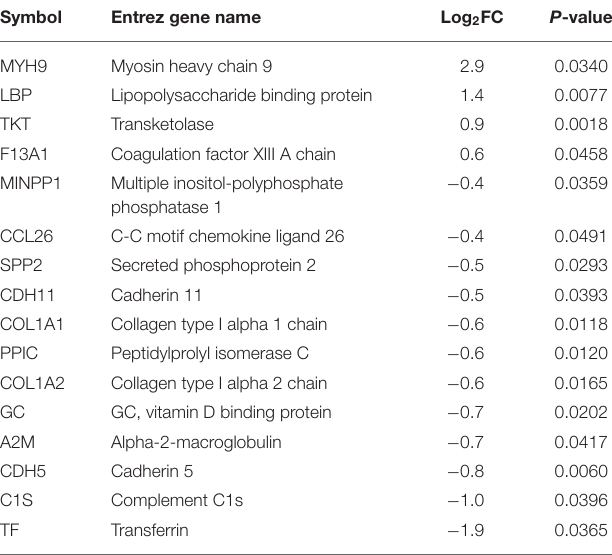
TABLE 2 | Plasma protein biomarkers in WB at 8 wks of age compared to Con. Symbol